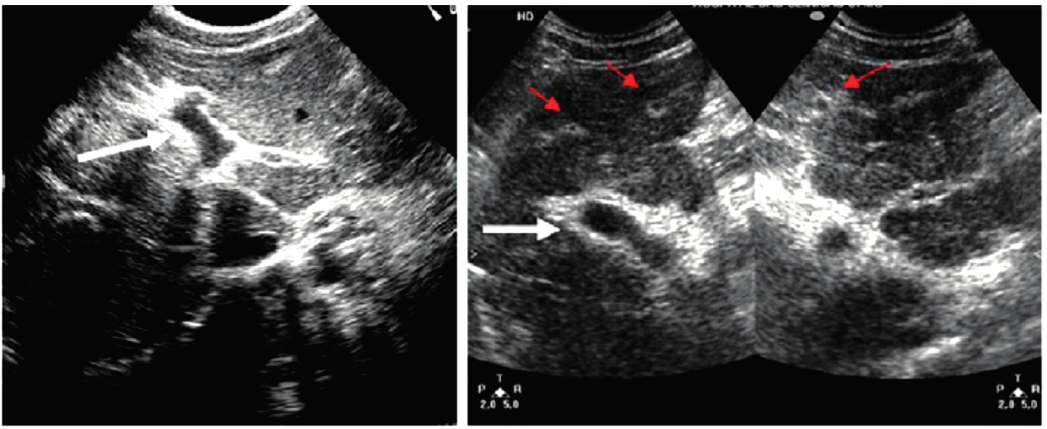
Figure 9. Ultrasound B-scans of the abdomen showing changes caused by schistosomiasis. White arrow: Central periportal fibrosis, red arrows: fibrosis on the periphery of the liver in a patient diagnosed with advanced hepatosplenic schistosomiasis Reproduced with permission